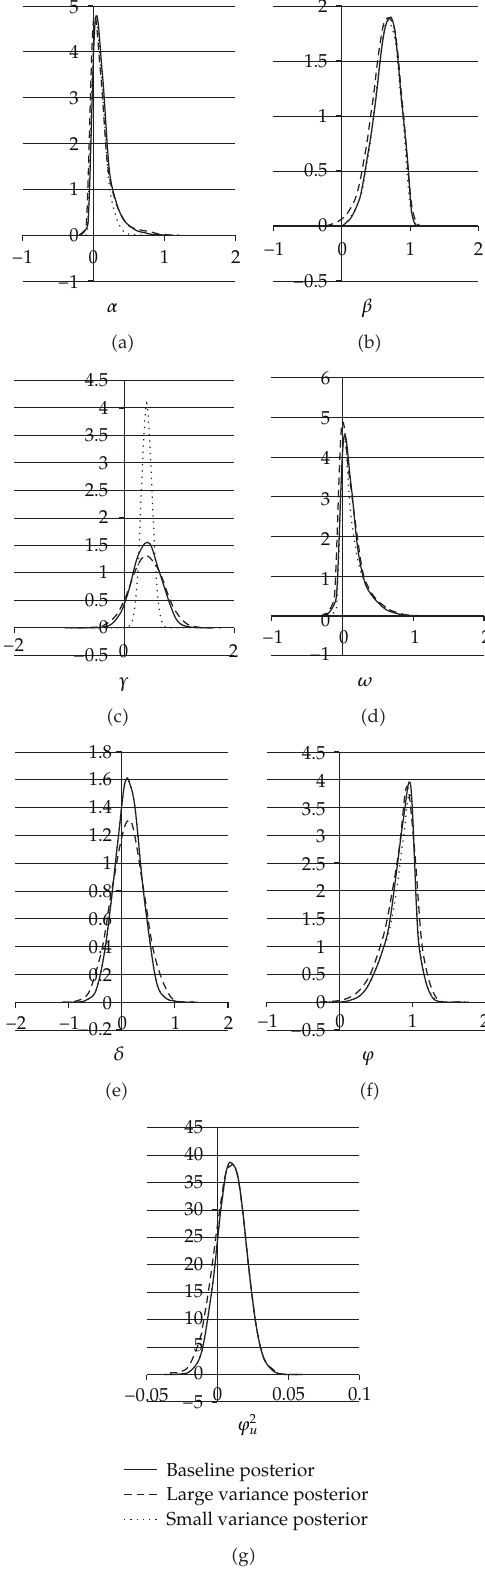
Figure 3: Nikkei: posterior density estimates and sensitivity